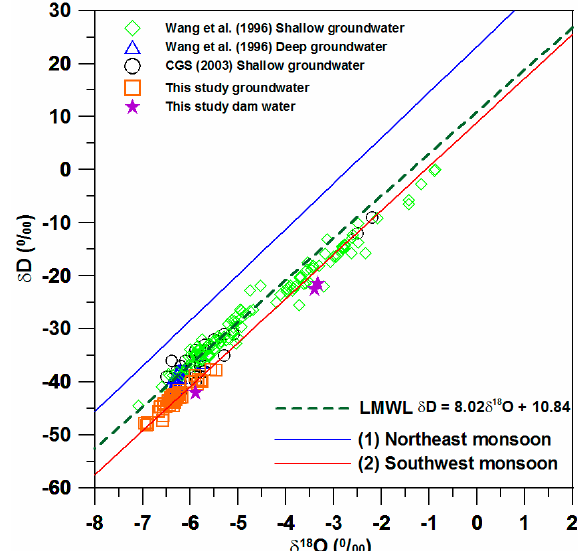
Figure 4. Plot of δ D vs. δ 18O for shallow and deep groundwater samples. (1) Isotopic composition of precipitation during northeast monsoon season in Taiwan (meteoric water line: δ D = 8.6 δ 18 O + 23.3); (2) Isotopic composition of precipitation during southwest monsoon season in Taiwan (meteoric water line: δ D = 8.3 δ 18 O + 9.0) (Peng et al. [28]).